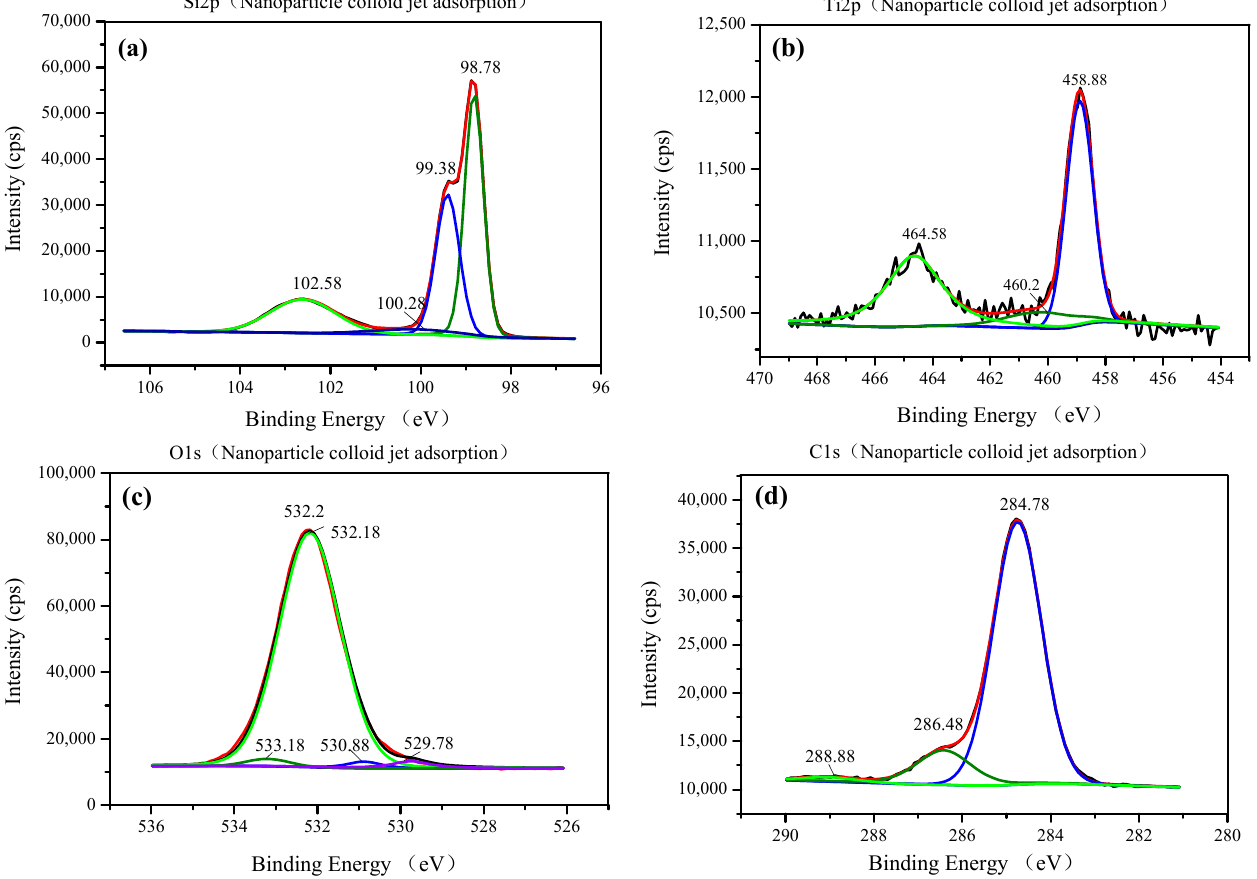
Figure 12. XPS spectra of nanoparticle colloid jet adsorption Si surface: ( a ) Si 2p, ( b ) Ti 2p, ( c ) O 1s, and ( d ) C 1s.